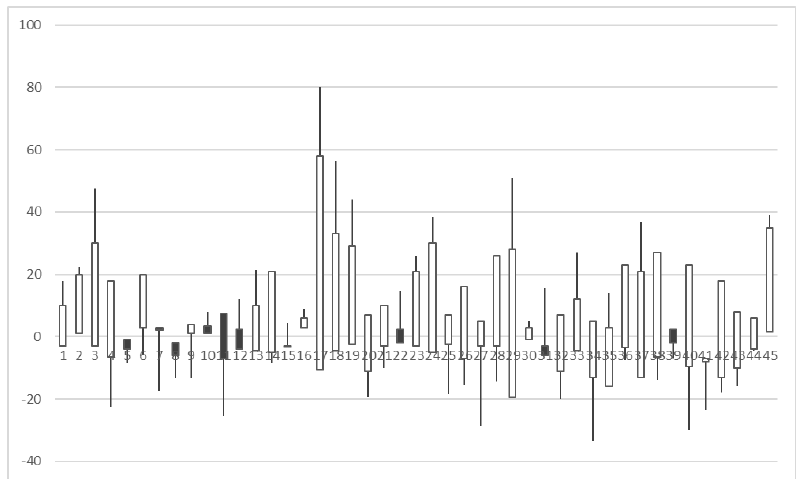
Figure 2. Seattle’s candlestick chart in 2012/2013 and 2013/2014.